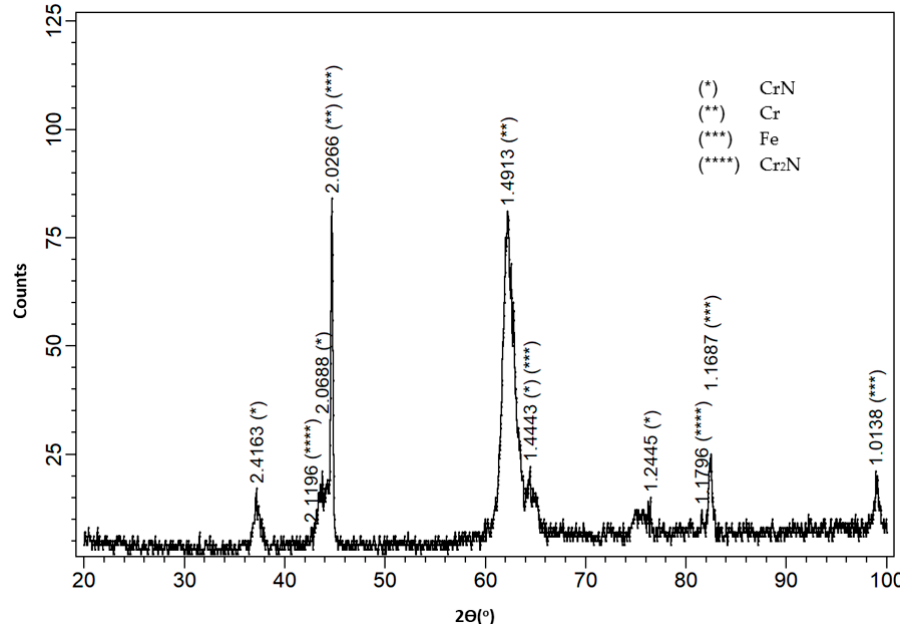
Figure 1. XRD pattern of Cr/CrN coating produced by means of the physical vapor deposition (PVD) method on AISI 1045 steel.